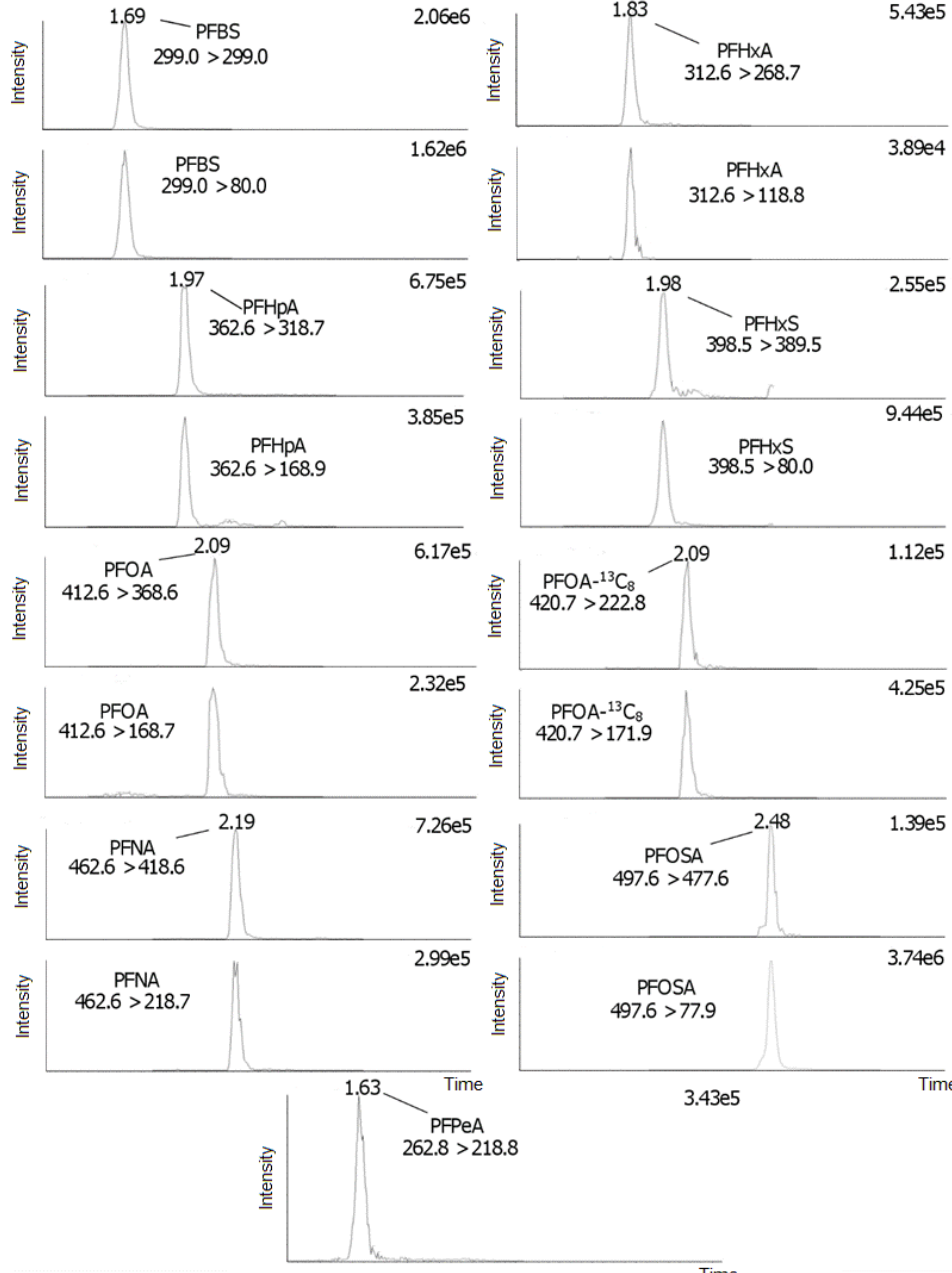
Figure 5. SRM ion chromatograms of PFBS, PFHxA, PFHpA, PFHxS, PFOA, PFOA- 13 C 8 , PFNA, PFOSA, and PFPeA.